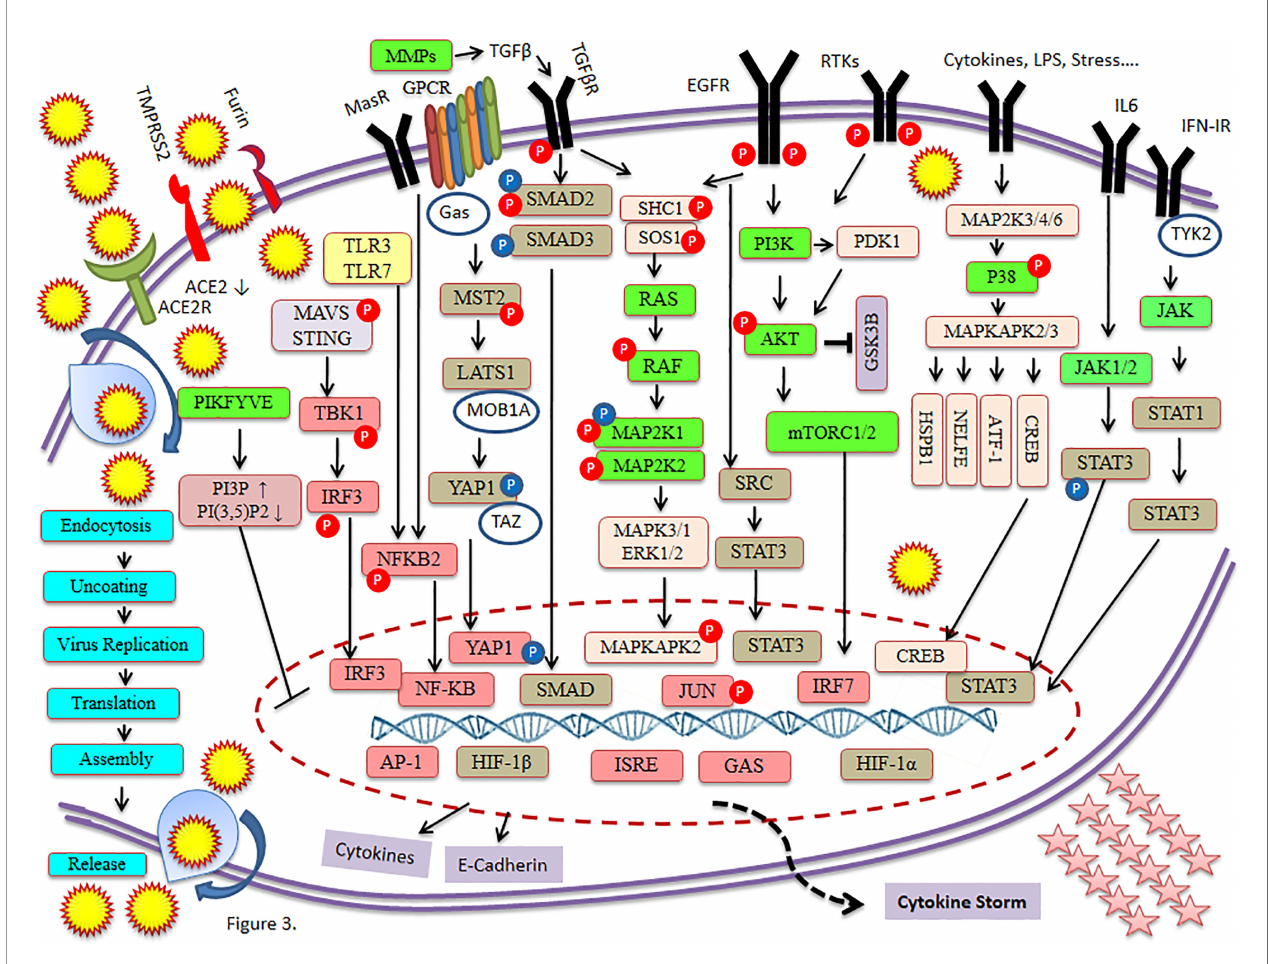
FIGURE 3 | Major signaling pathways involved in